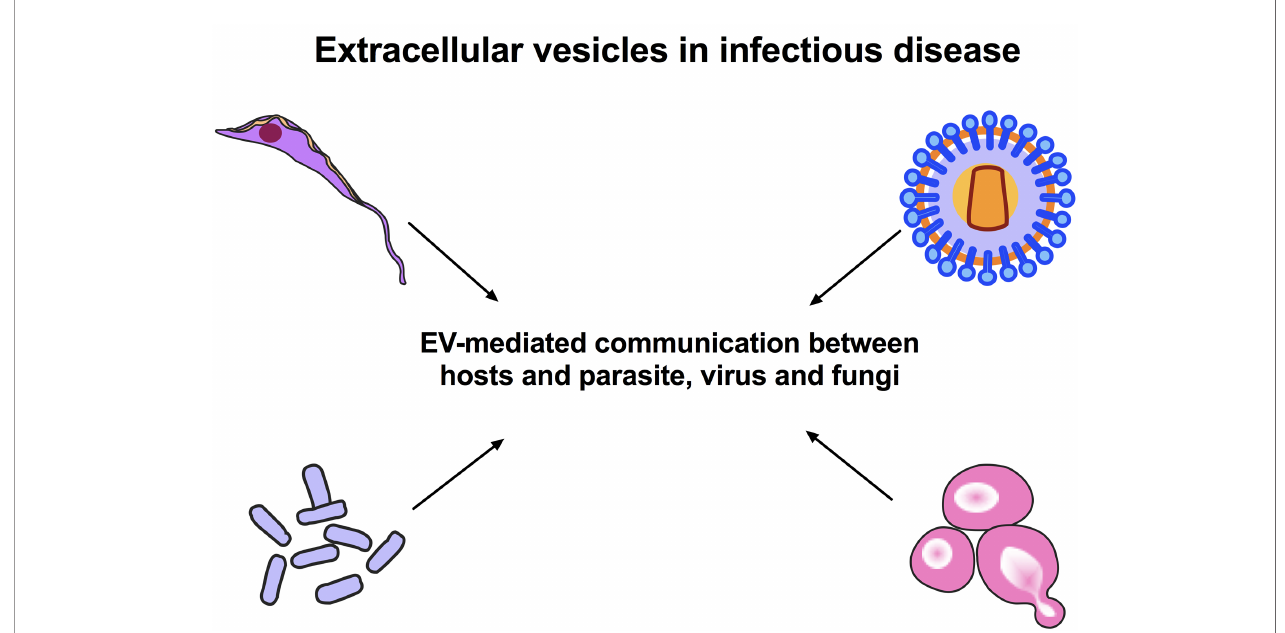
FIGURE 1 | Extracellular Vesicles in Infectious Diseases. EVs isolated from parasites, fungi and viruses are known to mediate communication under a variety of physiological and pathological conditions and modulate the host immune system. EVs are a new research area that can provide valuable information on how a pathogen sends messages to other pathogens and hosts. The fundamental point for the control of endemic parasitic diseases is an understanding of the mechanisms involved in the pathogen-host